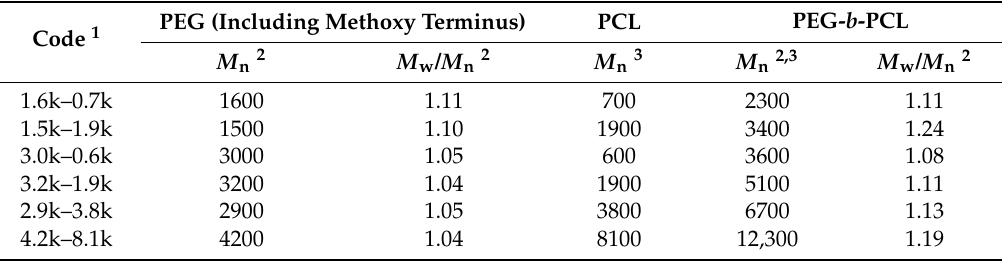
Table 1. The different compositions of poly(ethylene glycol)- block -poly( ε -caprolactone) (PEG- b -PCL) used in this